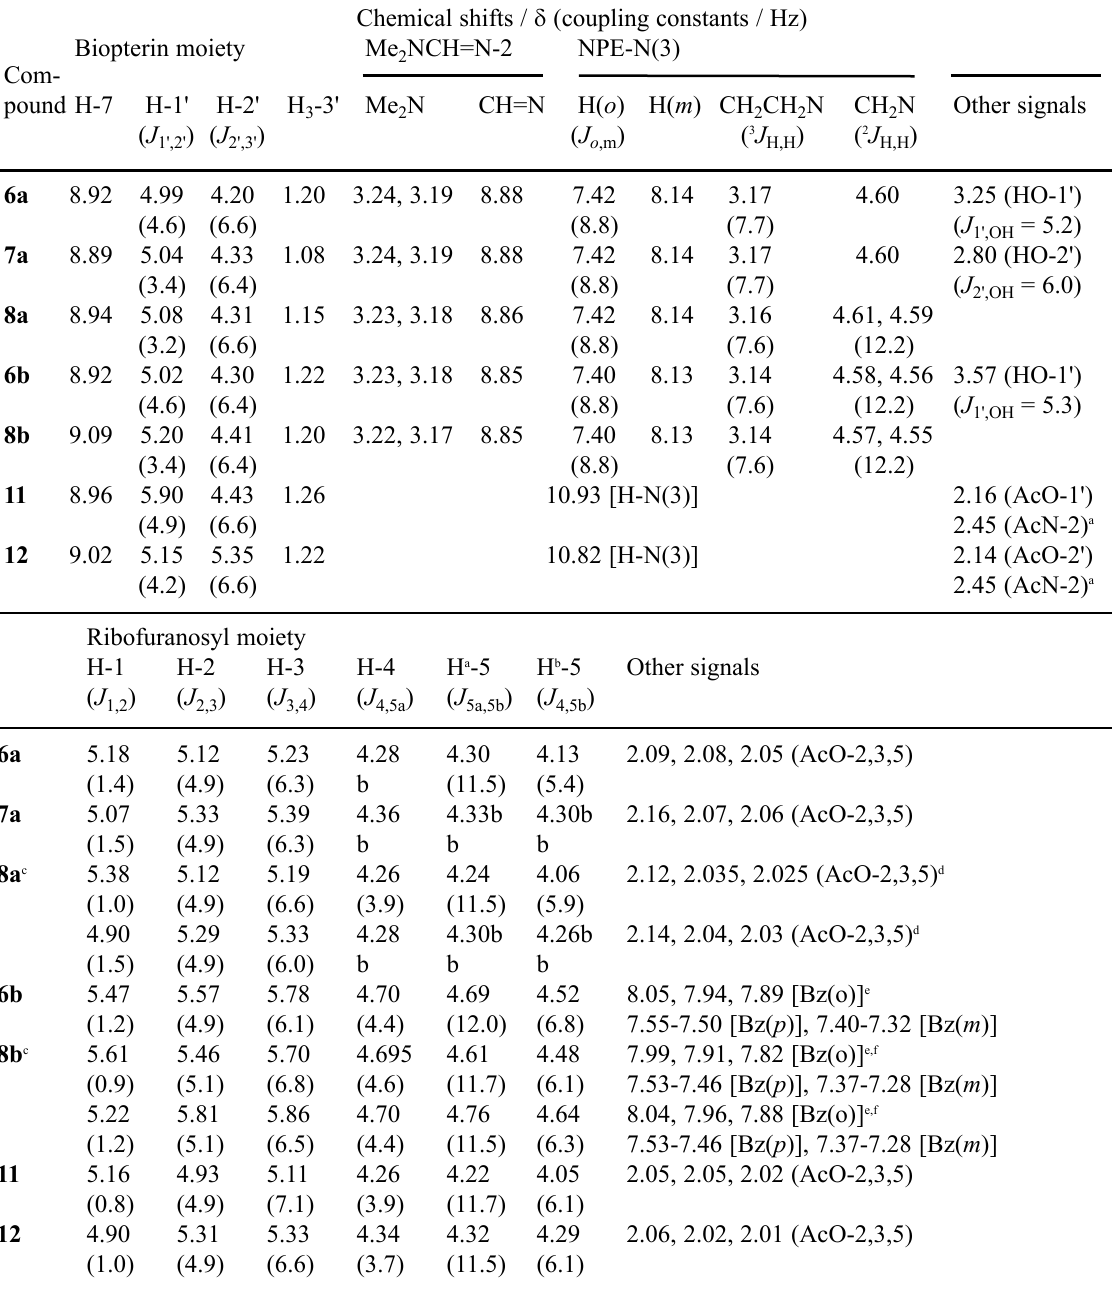
Table 2. 600 MHz 1 H-NMR Spectral parameters for 1'- and 2'- O -( β -D-ribofuranosyl)biopterin derivatives ( 6- 8a,b, 11, 12 ) in CDCl